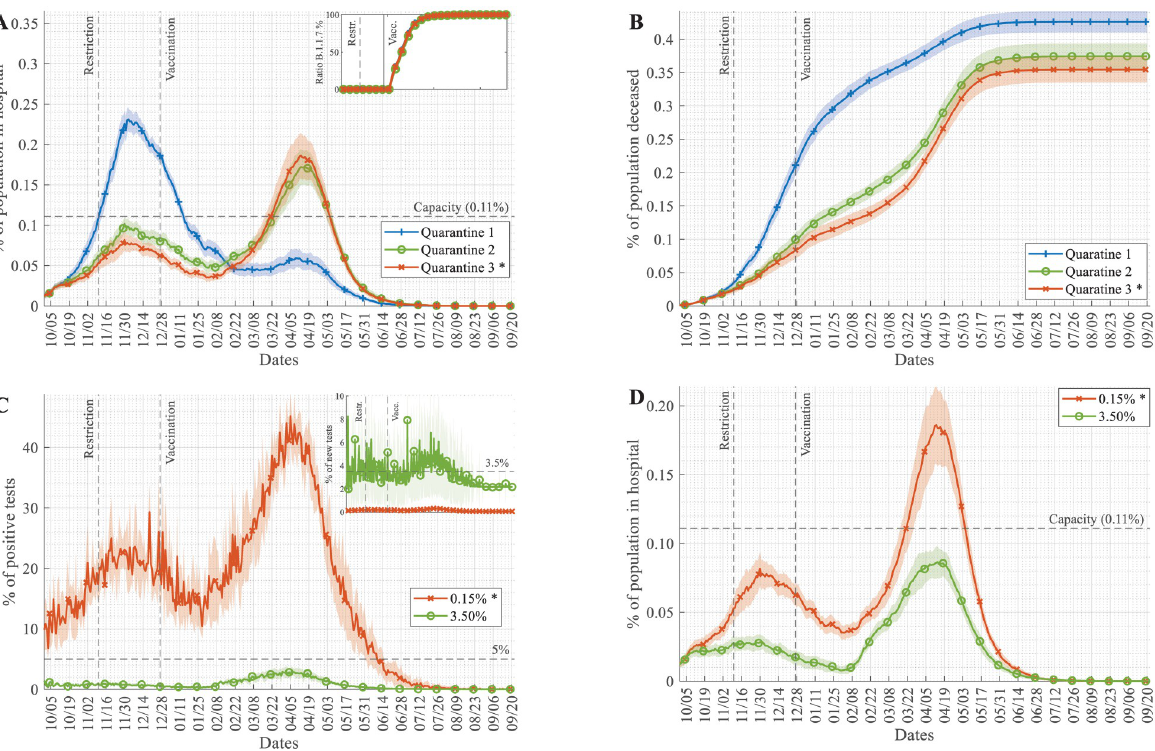
Fig 2. Variations in quarantine scenarios and testing intensities can slow down but not suppress the pandemics. (A-B) Time course of simulations with varied quarantine scenarios (Q1—diagnosed patient quarantined at home, Q2—diagnosed patient and household quarantined, Q3 —patient, household and workmates/classmates are quarantined) showing (A) the percentage of hospitalised COVID-19 patients in the population and (B) the accumulated number of death events due to COVID-19 scaled to the whole population. Appearance and spread of the B.1.1.7 variant are shown on the inset of panel A. Start date of restrictions and the start of vaccination are noted on plots. (C-D) The testing rate was increased from the reference scenario value of 0.15% of people tested daily, fitted to Hungarian data (Fig 1D and Fig E in S1 Text) to the highest level achieved by most actively testing countries (3.5% daily). (C) Time courses of the daily ratio of positive tests and (D) the percentage of hospitalised COVID-19 patients in the population each day (hospital burden) are plotted. Daily testing rates are shown on the inset of panel C. (Mean and std. of 30 simulations are